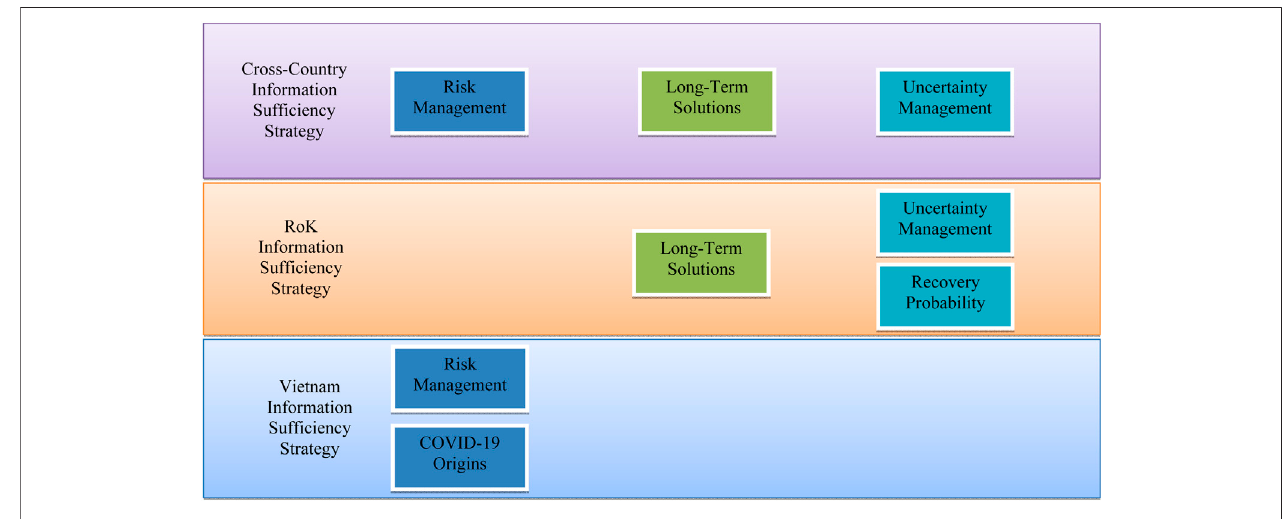
FIGURE 5 | Message strategies relevant in cross-cultural and single-cultural contexts to reduce information insuf fi ciency judgments during COVID-19.